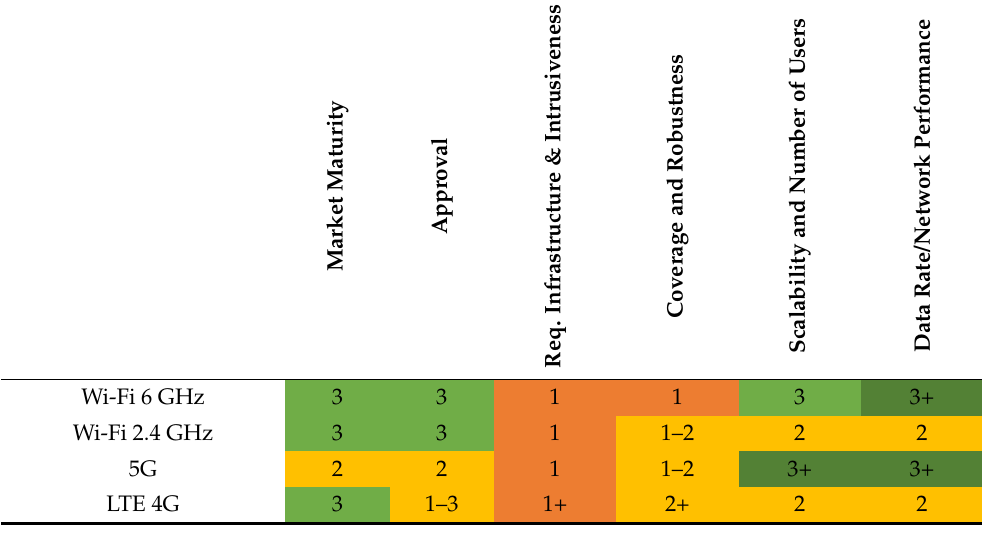
Table 1. Summarized Comparison and Evaluation of Wi-Fi, LTE/4G and